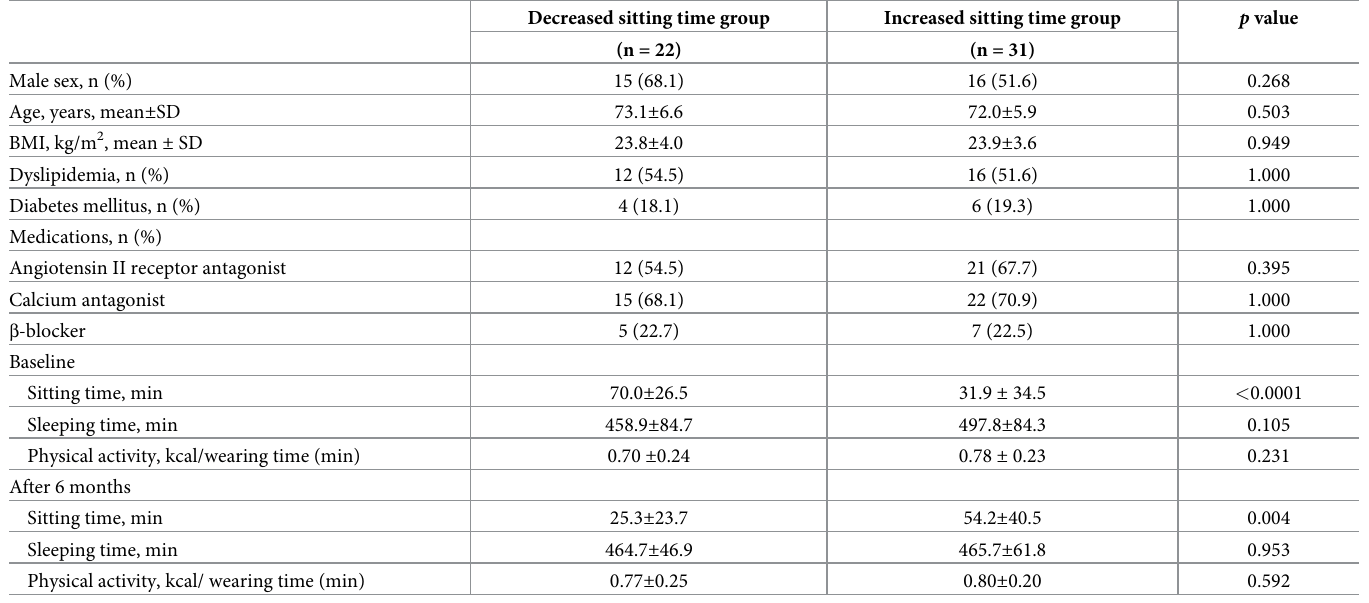
Table 1. Comparison of patient characteristics for the decreased sitting time and increased sitting time groups at baseline and after 6 months. Decreased sitting time group Increased sitting time group p